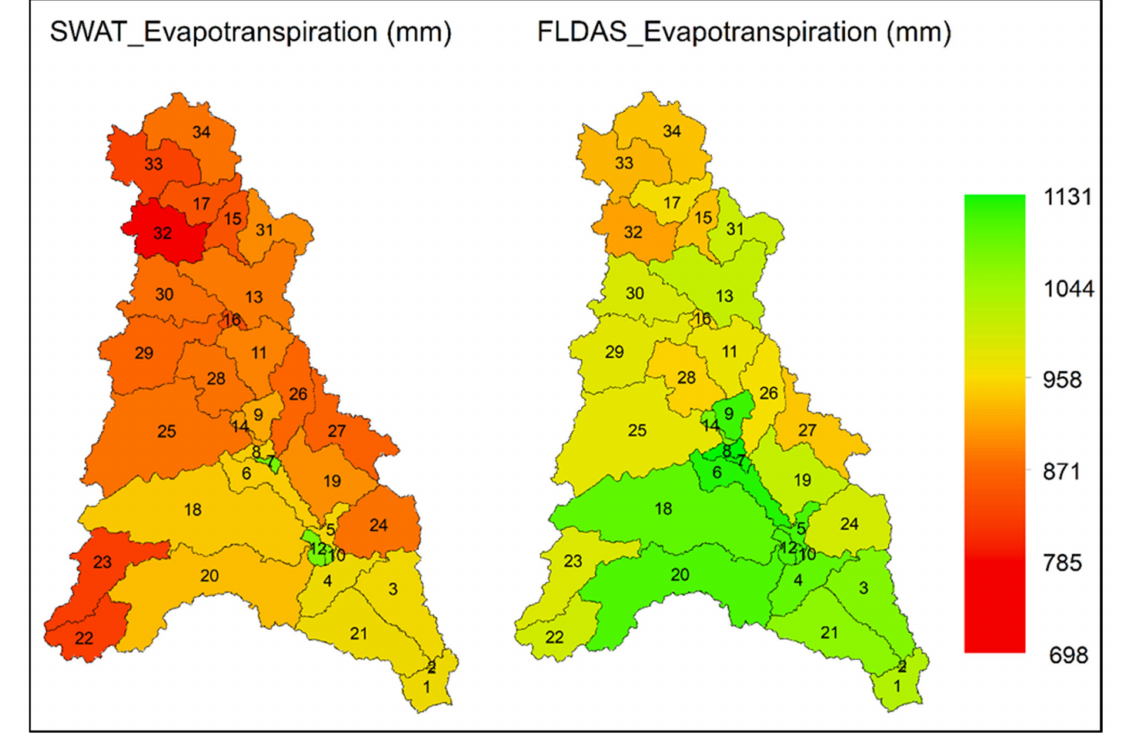
Figure 10. Spatial distribution of average annual evapotranspiration and its validation using FLDAS data over the Nagavali river basin for the period of 24 years (1991–2014).